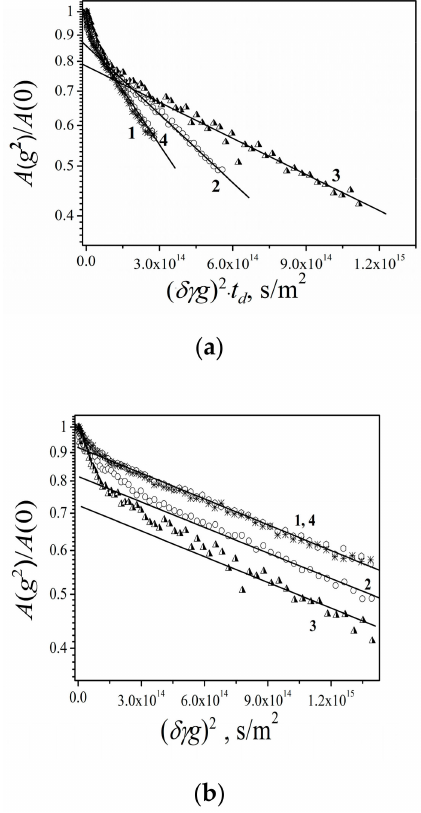
Figure 55. Dependence of the diffusion attenuation of spin–echo signal in solutions of α -casein on diffusion time [139]. Same diffusion attenuations are plotted using different coordinates: [43,140] ( a ) as a function of ( γδ g ) 2 t d and ( b ) as a funcTable 2. Diffusion attenuations are shown for 15% α -casein solution. Curves 1–3 correspond to diffusion attenuations collected at diffusion times 200, 400, and 800 ms, respectively. Curve 4 is a control experiment. The diffusion attenuation shown by curve 4 was collected at 200 ms after the completion of the experiments carried out at different values of t d